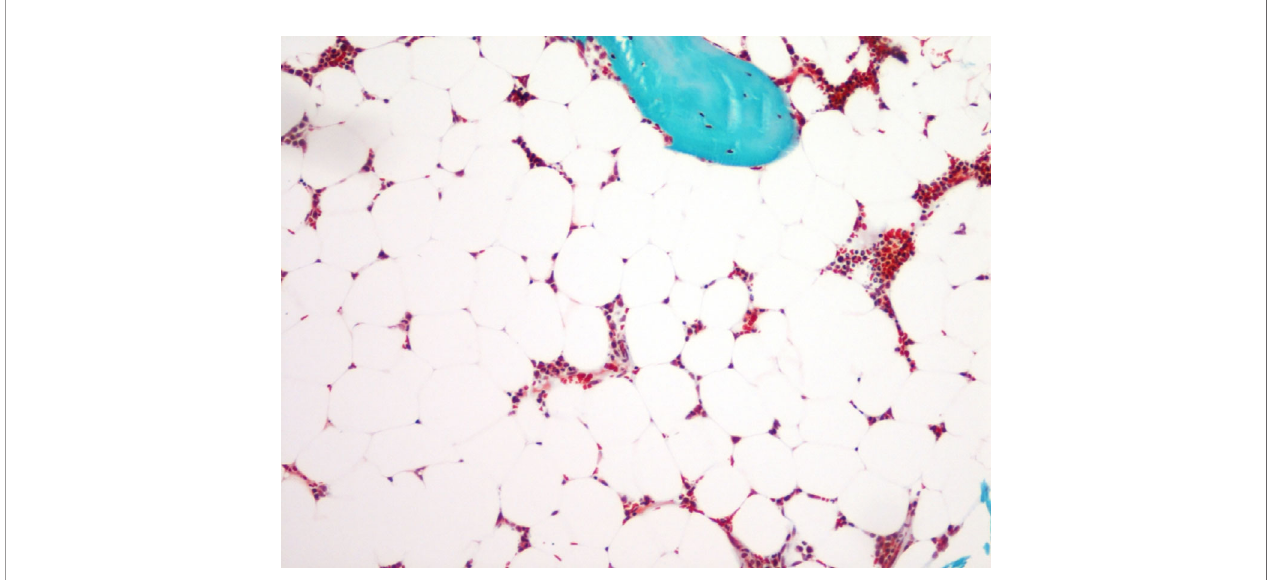
FIGURE 1 | Bone marrow adiposity in a human transiliac bone biopsy. Bone marrow adipocytes appear as “ gost ” cells in a Goldner ’ s stained section. Magni fi cation 10 ×